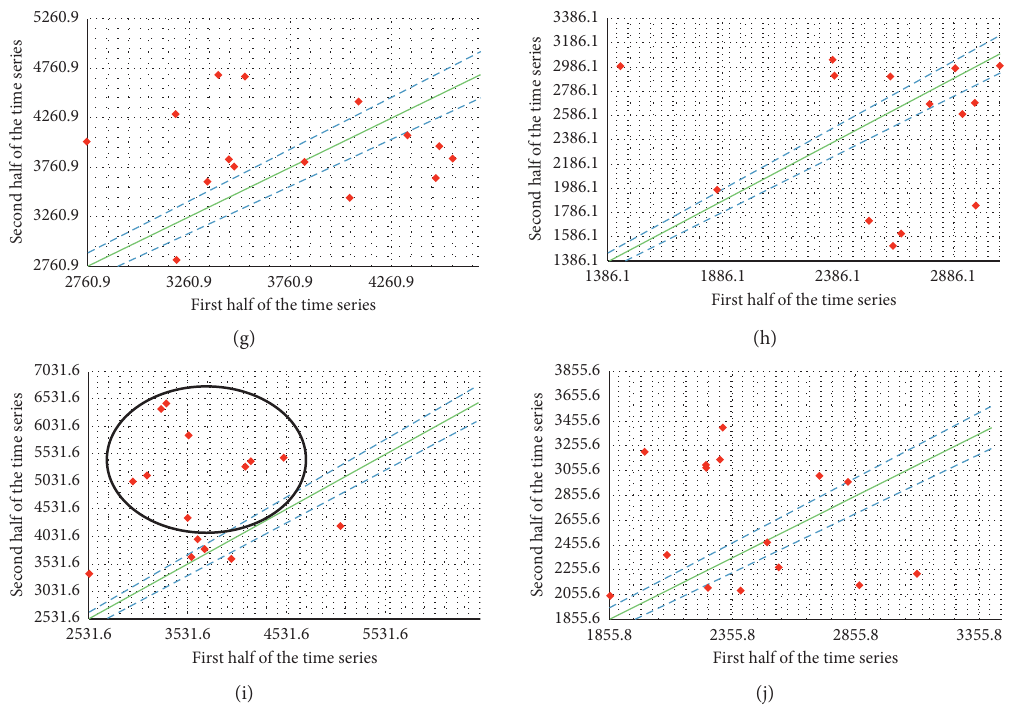
Figure 2: Graphical trends for annual rainfall. (a) Colombo. (b) Angoda. (c) Avissawella. (d) Dehiwala. (e) Hanwella. (f) Homagama.